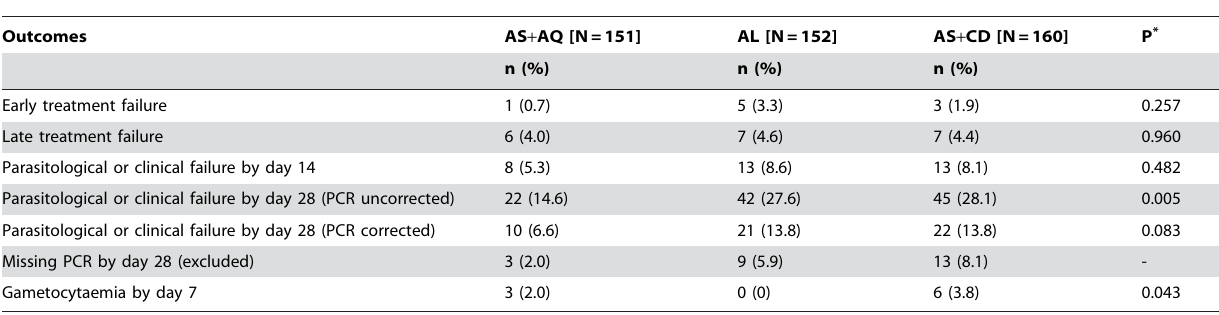
Table 2. Treatment outcomes (per protocol analysis).